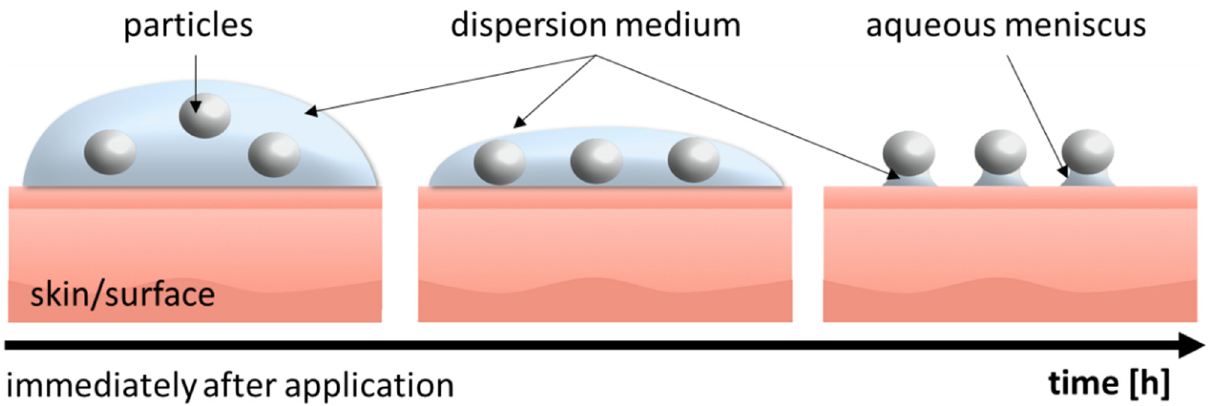
Figure 2. Scheme of aqueous meniscus formation after topical application of particle-containing der- mal formulations.